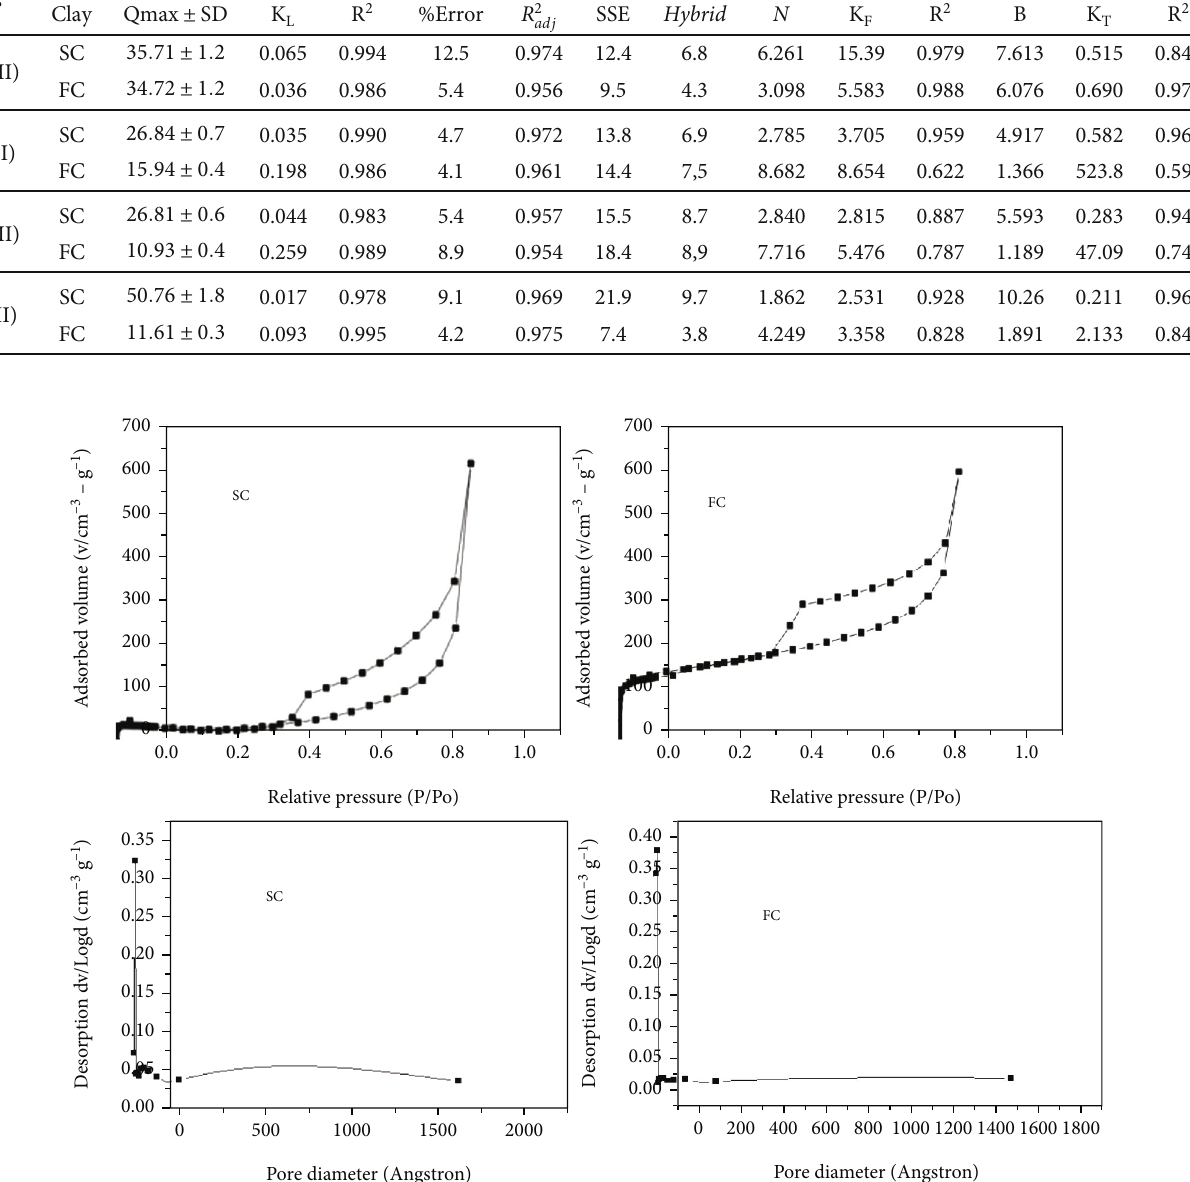
Figure 3: BET surface area plots and pore size distribution of the sodium clay (SC) and ferric clay (FC).